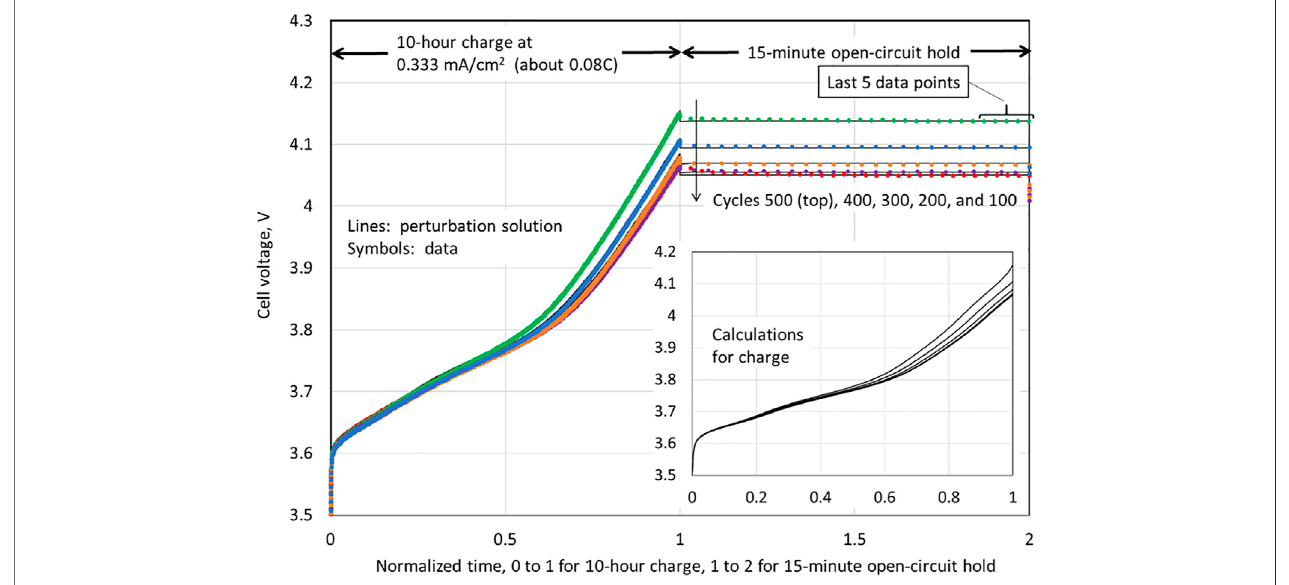
FIGURE 7 | Experimental results (symbols) and calculations. The inset plot in the lower right shows only the calculations.